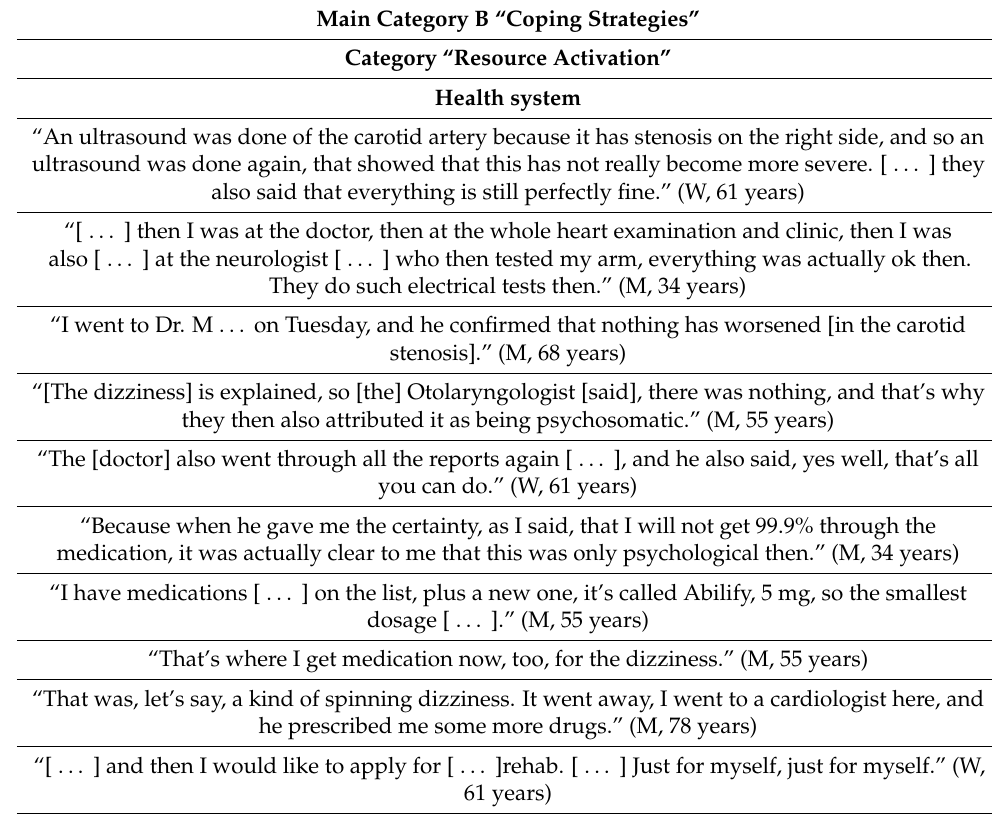
Table A2. Example quotes on the themes and categories within main category B “Coping